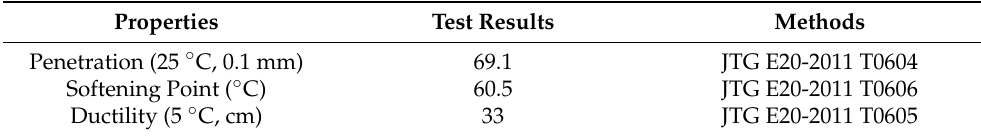
Table 1. Basic properties of modified